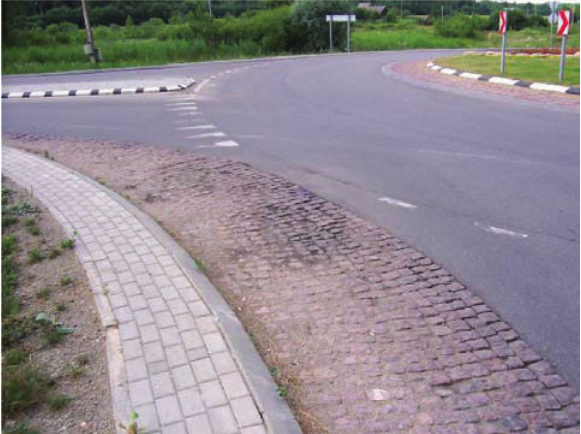
Fig. 11. The damaged block pavement on the widened